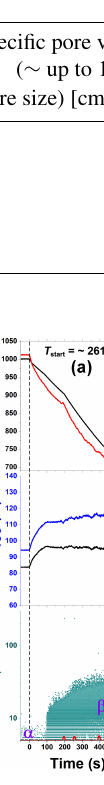
Table 1. Sources, specific surface areas, pore volume, and the median diameter of coal fly ash aerosol particles used in this study. Argon gas was used for the BET measurements; hence, it is labelled as BET Ar . The median diameter was determined from the combined data of the APS and the SMPS instruments. The details of the samples and labels are given in Sect. 2.1. The countries that the samples originated from are the United Kingdom (UK) and the United States of America (USA).